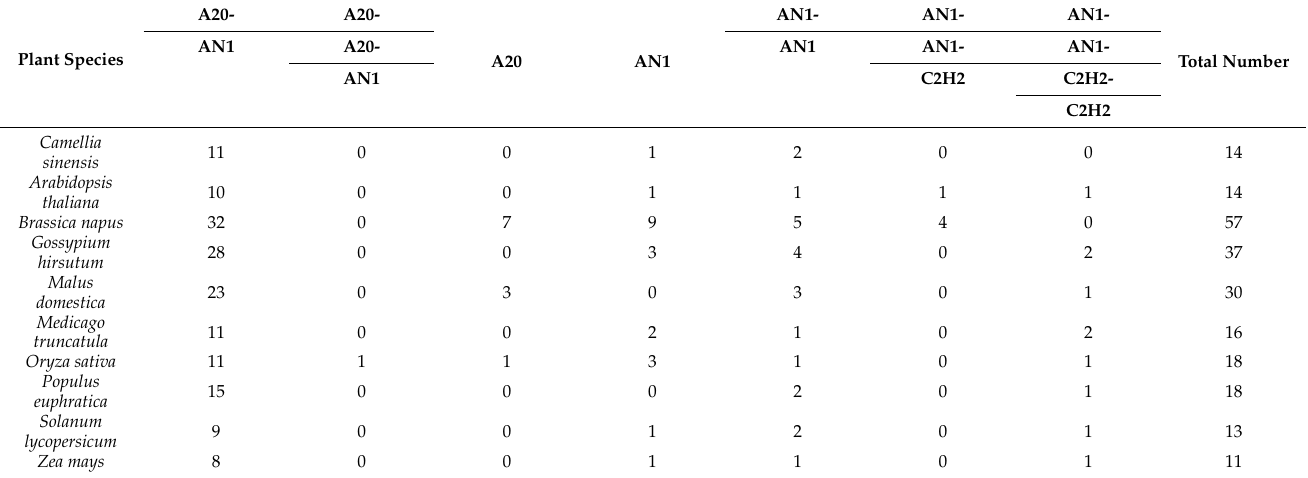
Table 3. Numbers of SAP gene family members in various